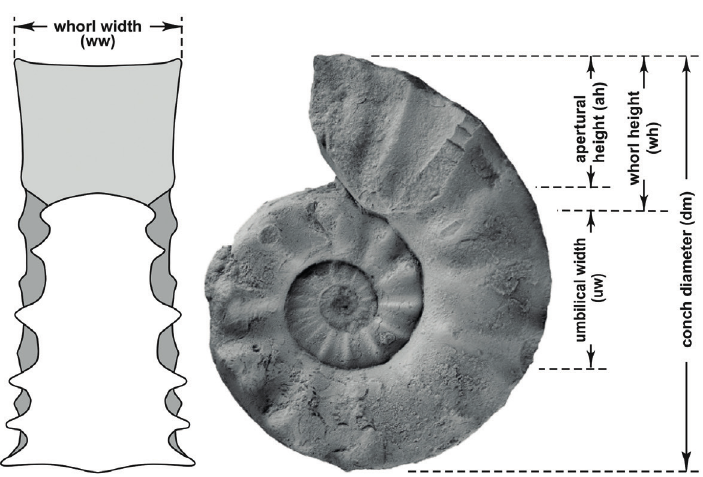
Fig. 14. Descriptive terms for the conch geometry of the ammonoids described here (from Korn et al .